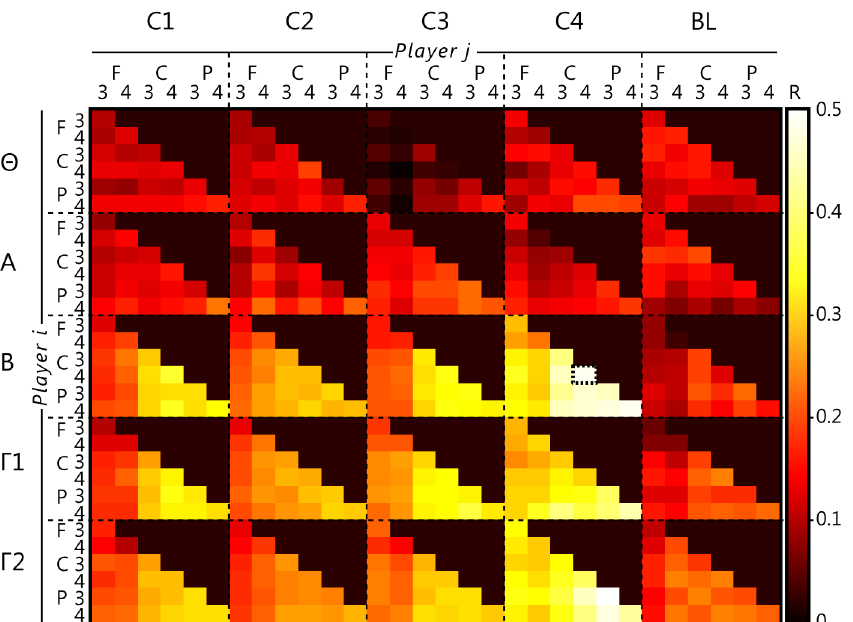
Figure 5. Tonic EEG linkage. Correlation of power between epochs in five frequency bands (theta, H : 4–8 Hz, alpha, A: 8–12 Hz, beta, B: 13–28 Hz, gamma, C 1: 30–45 Hz and higher gamma, C 2: 55–80 Hz) between the EEG of two participants over six electrodes (F3/4, C3/4, P3/4) as a function of competition (C1: cooperative, C2: competitive against computer, C3: competitive with computer, C4: against one another, BL: baseline). As an example, the dotted line surrounding a single cell (also indicating the highest difference compared to baseline), occurs in condition C4, beta frequency band, between the right central electrode (C4) of player i and of player j .